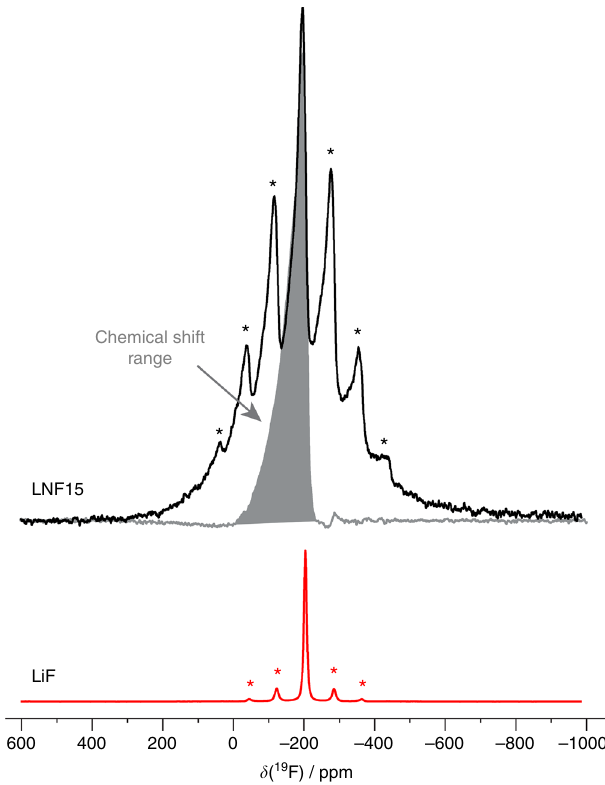
Fig. 3 19 F spin echo nuclear magnetic resonance (NMR) spectra obtained at 30 kHz magic-angle spinning (MAS) for Li 1.15 Ni 0.45 Ti 0.3 Mo 0.1 O 1.85 F 0.15 (LNF15) and LiF. Spinning sidebands in the spin echo spectra are indicated with an asterisk. The 19 F projected magic-angle turning phase-adjusted sideband separation (pj-MATPASS) isotropic spectrum collected on LNF15, shown with a gray shading, reveals the presence of broad, overlapping signals spanning a wide range of resonant